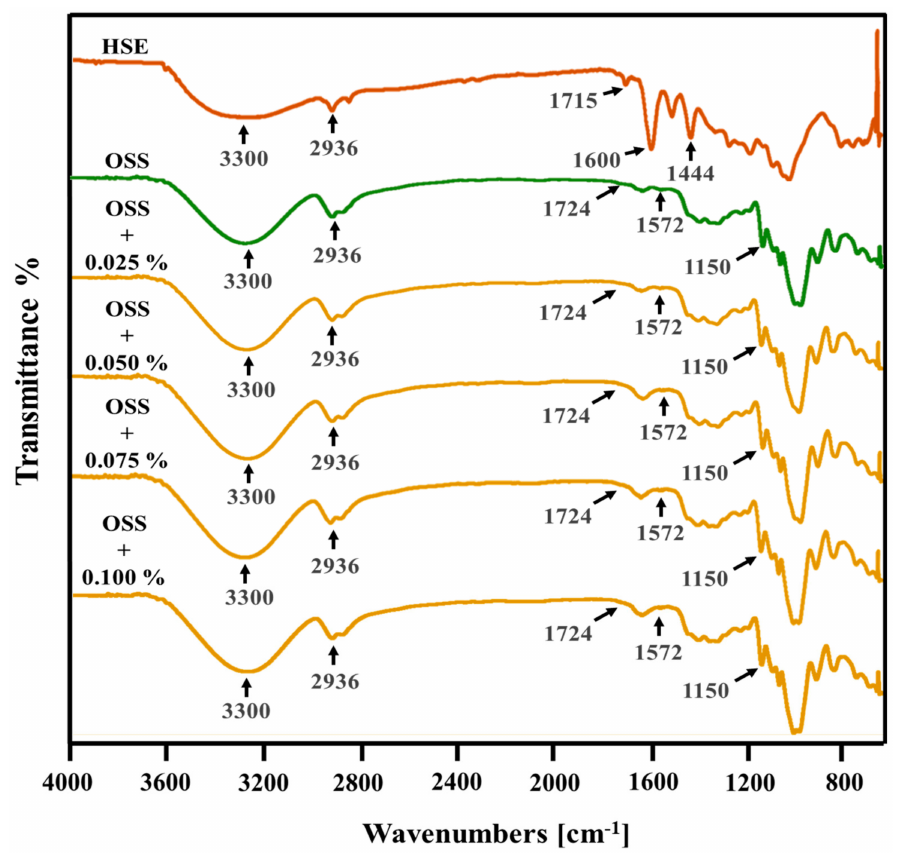
Figure 7. Fourier transform infrared (FTIR) spectra of hazelnut skin extract and octenyl succinate starch films with hazelnut skin extract. HSE: Hazelnut skin extract, OSS: octenyl succinate